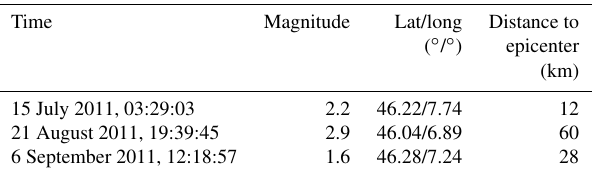
Table 3. Source parameters of earthquakes used in the site amplifi- cation